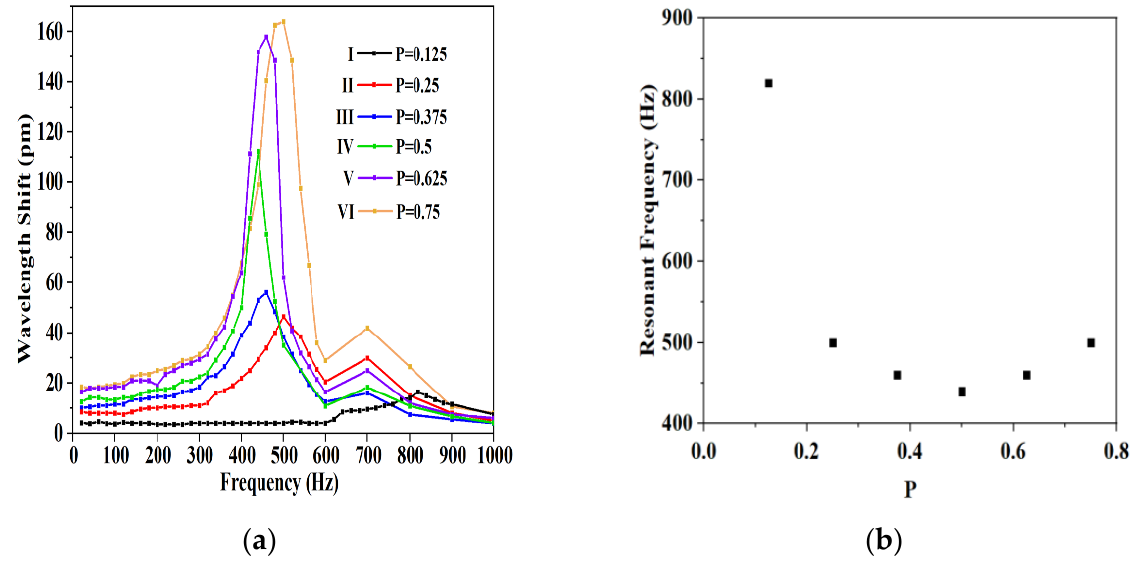
Figure 6. ( a ) Amplitude – frequency characteristic curves of accelerometers 1 – 6. ( b ) The relationship between resonance frequency and P .